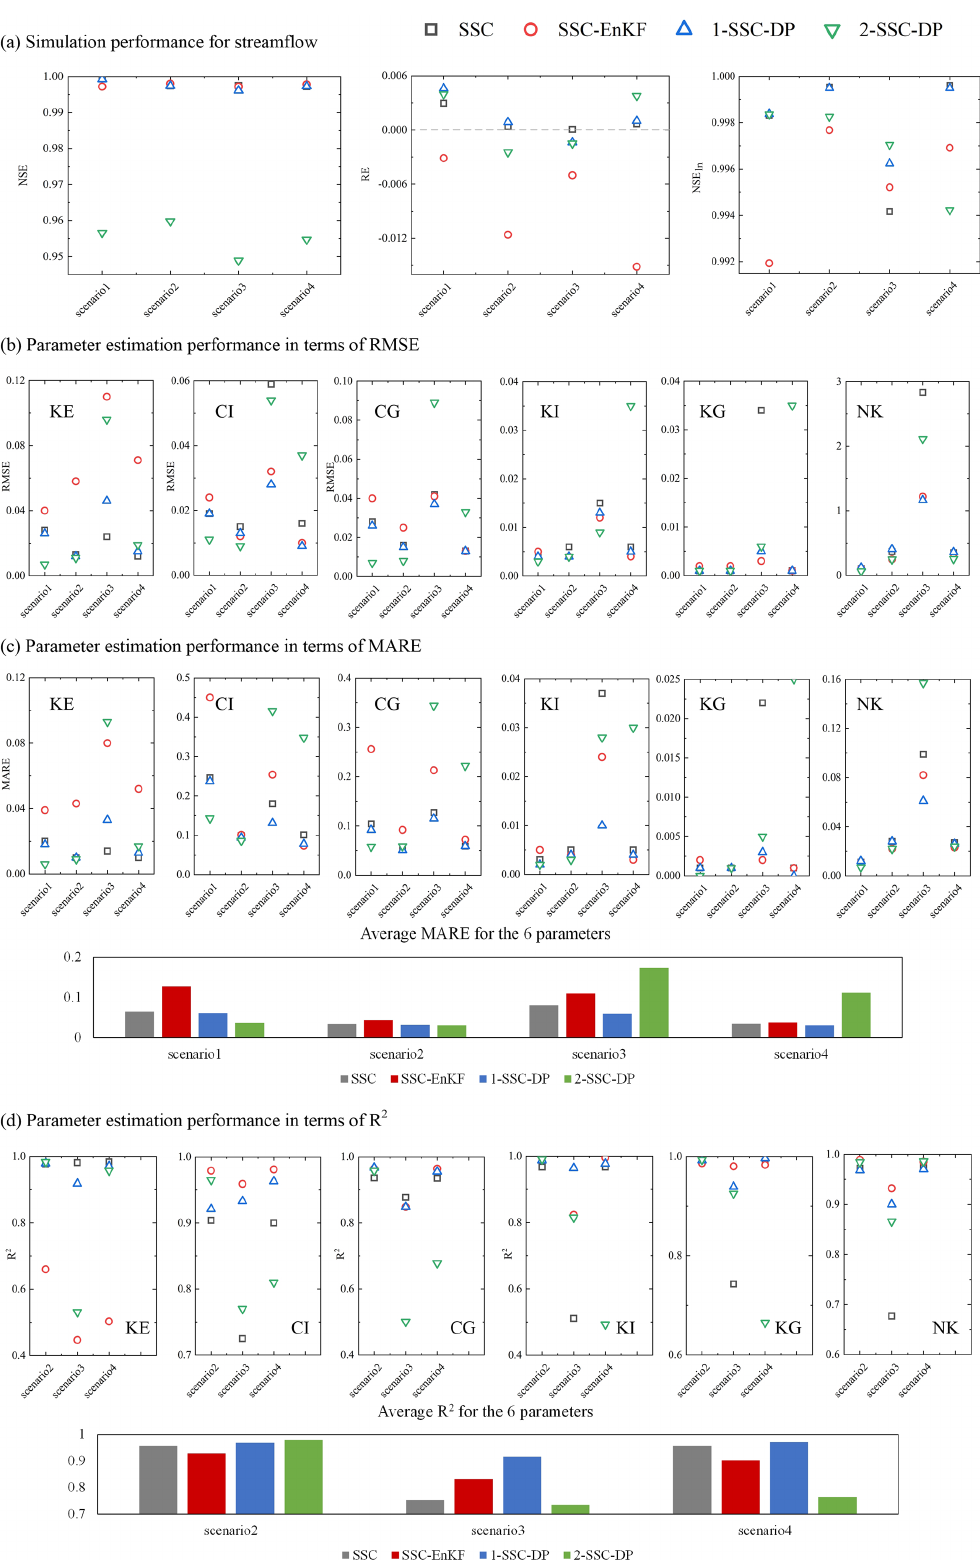
Figure 9. Comparison among the SSC, SSC-EnKF, and SSC-DP methods in the synthetic experiment with the Xinanjiang model for (a) streamflow simulation and parameter identification in terms of (b) RMSE, (c) MARE, and (d) R 2 .